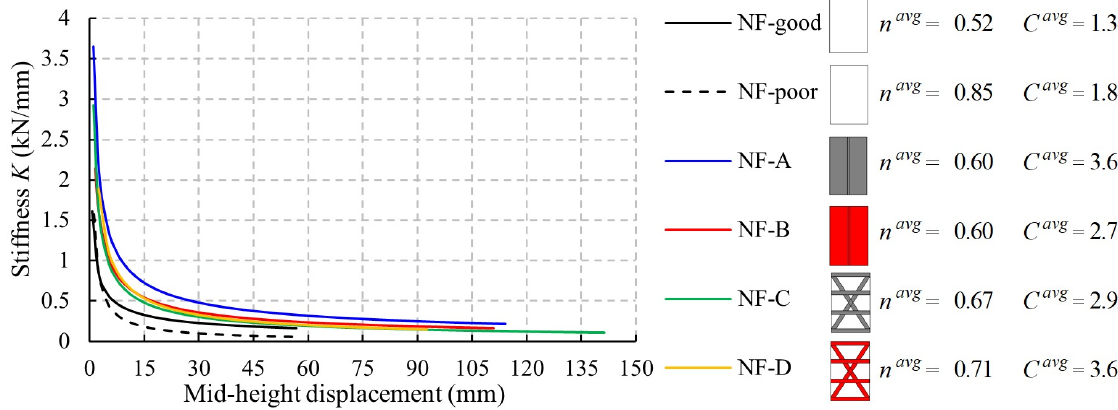
Figure 12. Comparison of stiffness degradation curves.